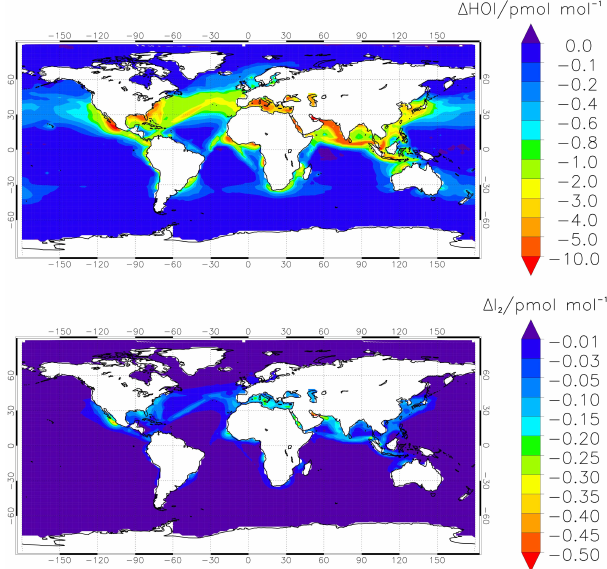
Figure 7. Modelled annual average of HOI (a) and I 2 (b) during nighttime (from 00:00 to 01:00LT) at the surface level. The panels show the difference in volume mixing ratio between the simulations with and without Reactions (R1) and (R4).